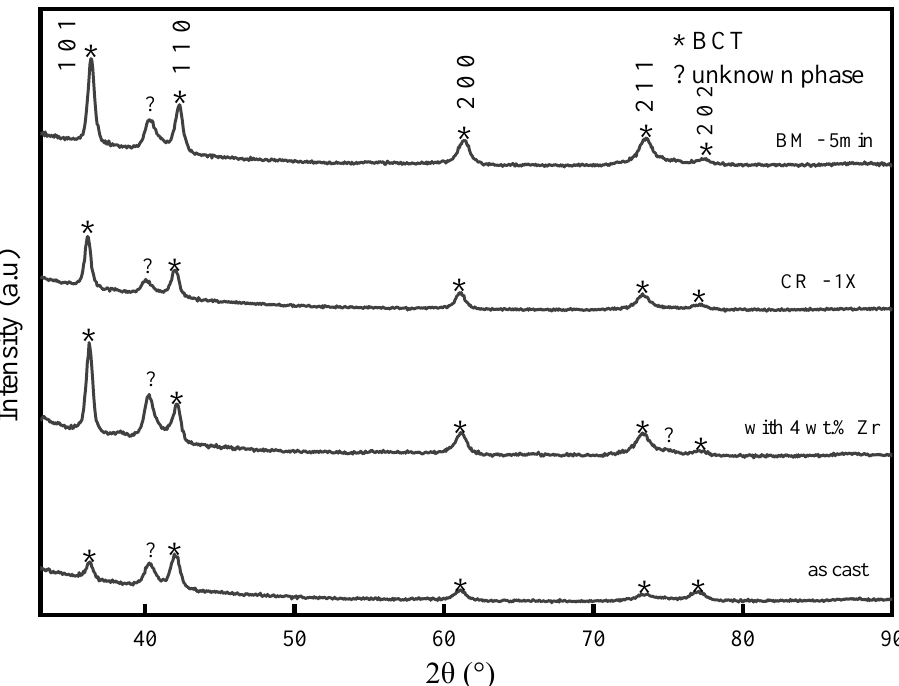
Figure 5. The XRD patterns of all studied Ti 16 V 60 Cr 24 alloys after hydrogenation (? is identified as the unknown phase). Table 3. Crystal parameters of Ti 16 V 60 Cr 24 alloys after hydrogenation.